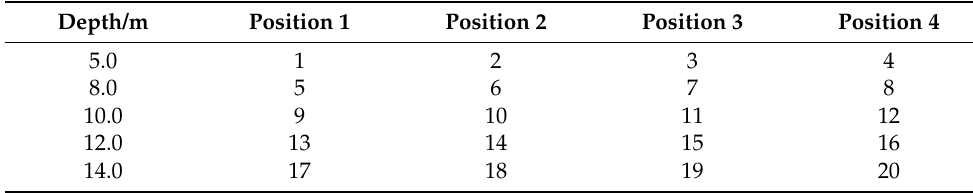
Table 2. Numerical simulation case